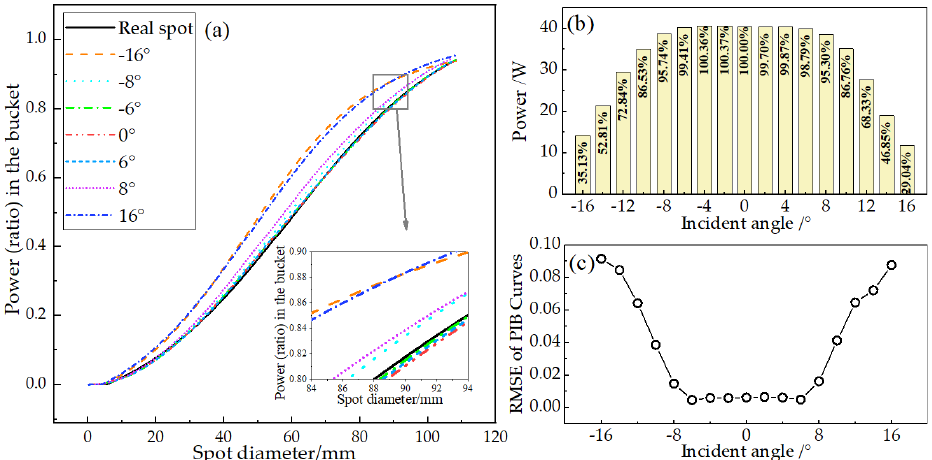
Figure 6. ( a ) PIB curves of the measured spots at different incident angles and the actual spot; ( b ) absolute value of the measured total power and their ratios relative to the true power when the incident angle changes between − 16° and 16°; ( c ) RMSEs of the PIB curves of the measured spots and the actual spot.